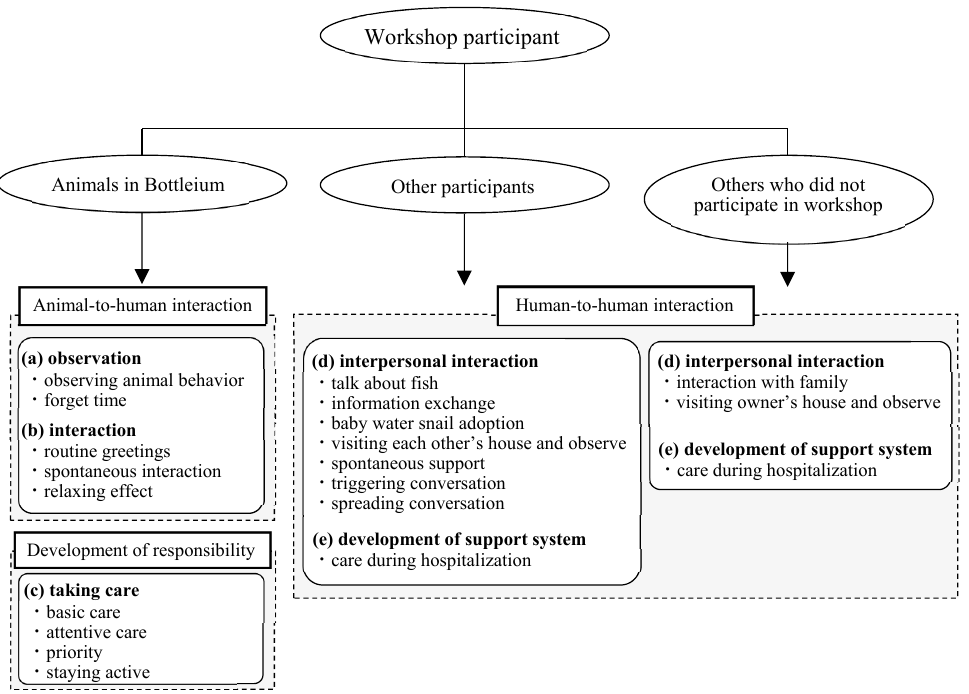
Figure 2. The relationship between workshop participant and animals in Bottleium, other participants and others who did not participate in workshop.